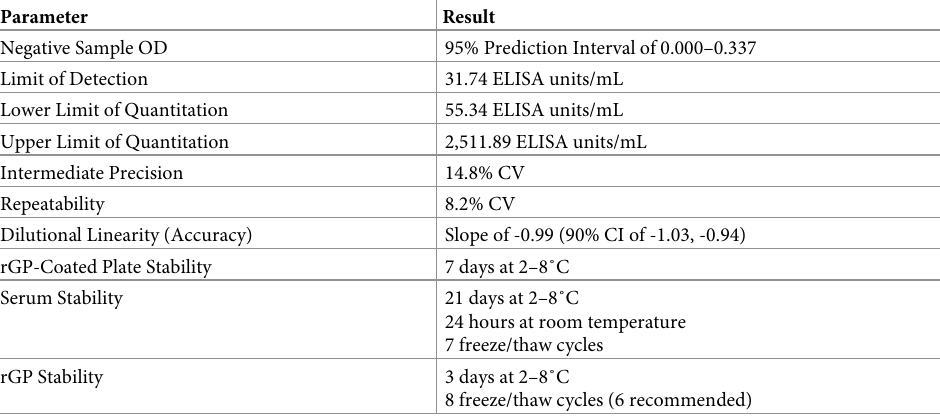
Table 2. Summary of anti-EBOV GP IgG ELISA qualification